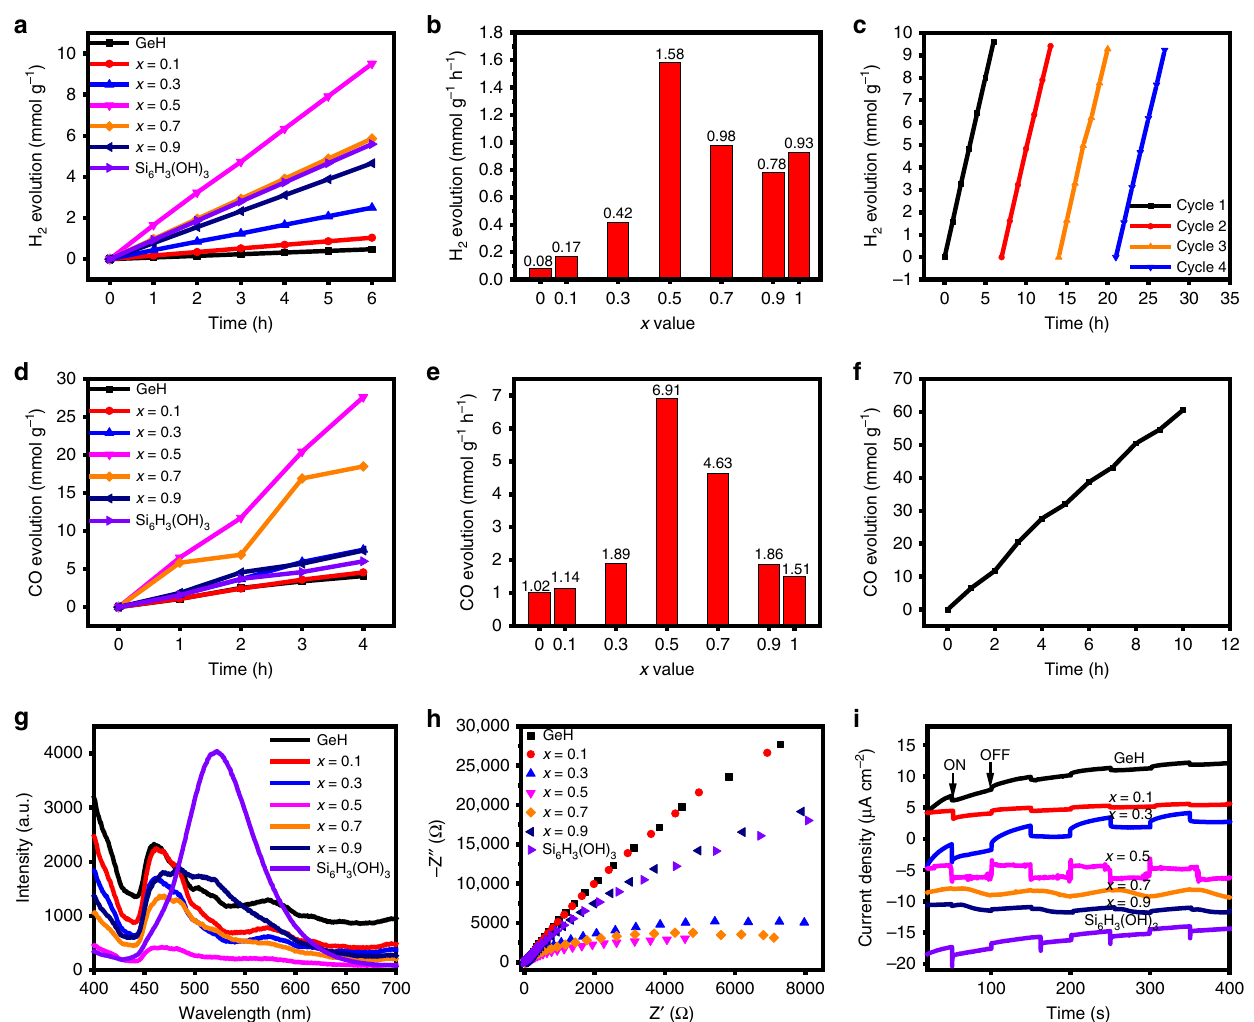
Fig. 6 Photocatalytic performance and electrochemical characterization. a , b Time-dependent photocatalytic hydrogen evolution ( a ) and HERs ( b ) of gersiloxenes with x = 0.1 − 0.9, GeH and Si 6 H 3 (OH) 3 . c Photostability for H 2 production of the gersiloxene with x = 0.5 (HGeSiOH). d , e Time-dependent photocatalytic CO evolution ( d ) and COERs ( e ) of gersiloxenes with x = 0.1 − 0.9, GeH and Si 6 H 3 (OH) 3 . f Time-dependent photocatalytic CO evolution for 10 h. g – i PL spectra ( g ), EIS Nyquist plots ( h ) and transient photocurrent responses (300 W xenon lamp) ( i ) of gersiloxenes with x = 0.1 − 0.9, GeH and Si 6 H 3 (OH) 3 . HERs, H 2 evolution rates. COERs CO evolution rates, PL photoluminescence, EIS electrochemical impedance spectroscopy. Source data are provided as a Source Data fi